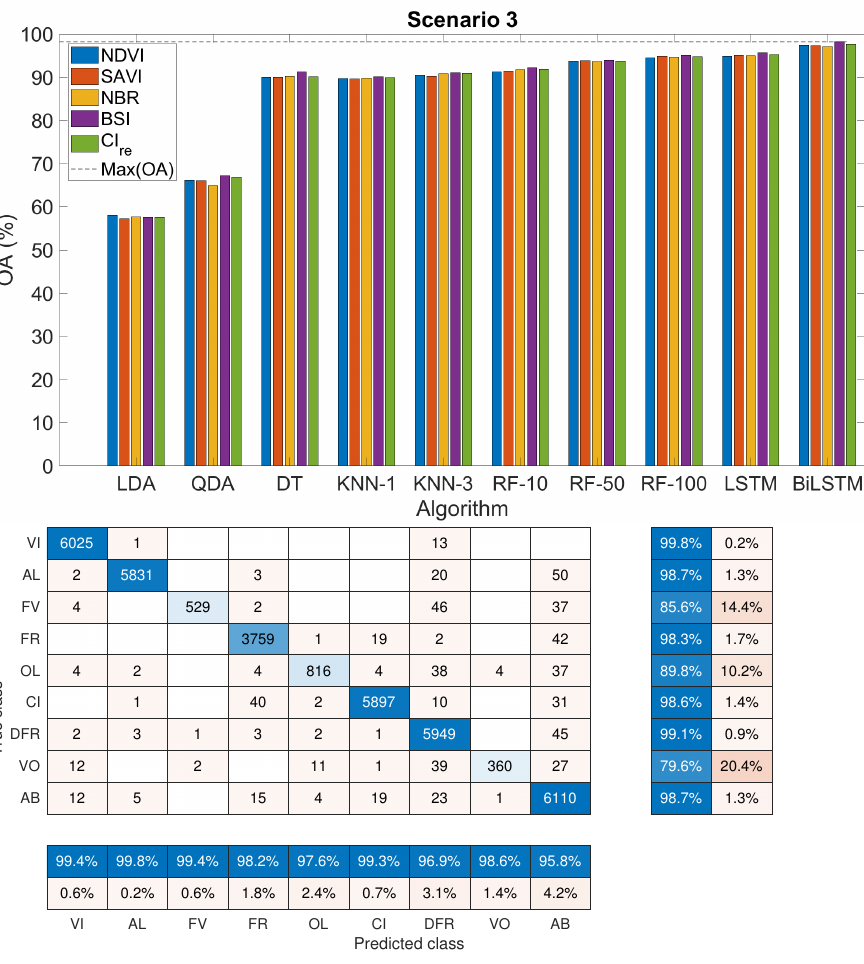
Figure 6. Results for scenario 3: ( top ), accuracies. ( bottom ), confusion matrix of the best model (2-BiLSTM trained with the BSI